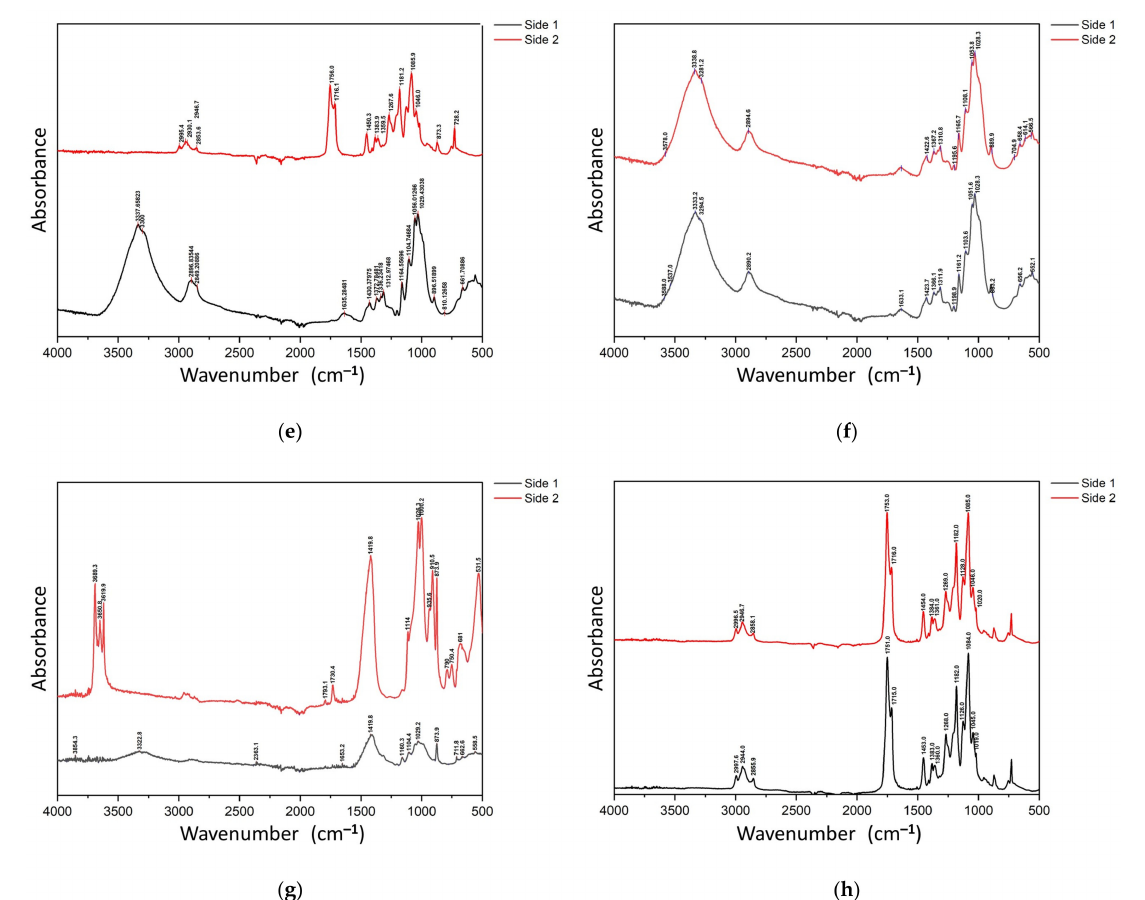
Figure 2. Fourier-transform infrared spectra of biopolymers; ( a ) Product 1; ( b ) Product 2; ( c ) Product 3; ( d ) Product 4; ( e ) Product 5; ( f ) Product 6; ( g ) Product 7; ( h ) Product